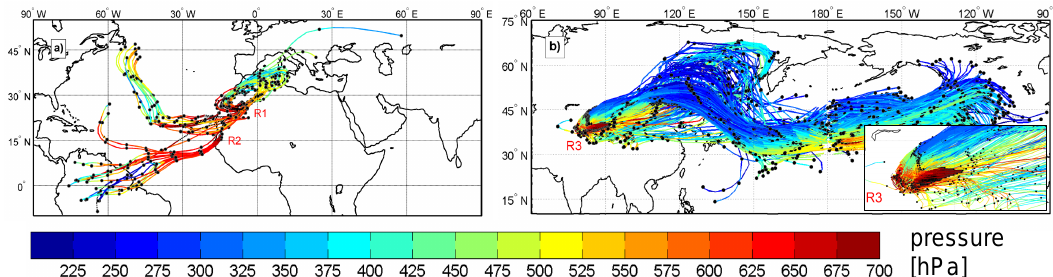
Fig. 3. Trajectories started from 700hPa in African dust plume regions R1 and R2 (a) and in Asian dust plume region R3 (b) that ascended to altitudes above the 450-hPa level. Black dots indicate trajectory locations at 24-h intervals while color along a trajectory indicates its pressure